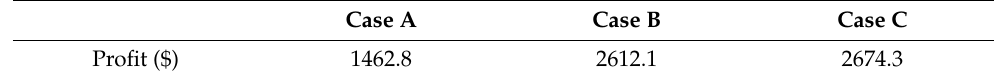
Table 3. Comparative analysis of the